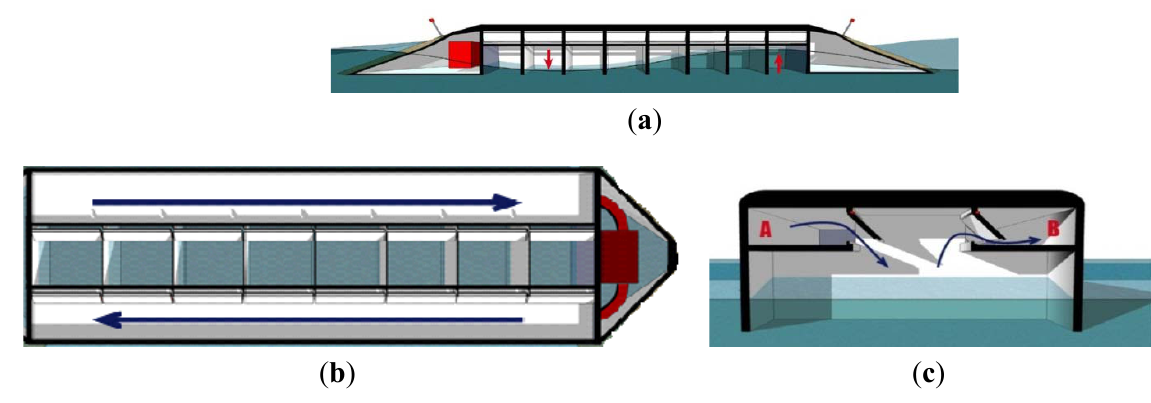
Figure 5. The Seabreath concept: ( a ) Longitudinal view; ( b ) Plan view; ( c ) Cross section.